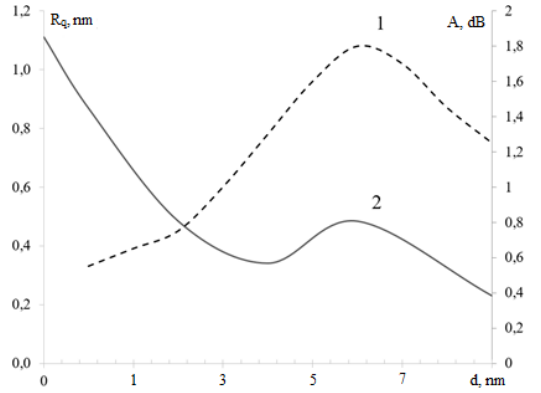
Fig. 4. Dependence on film thickness: 1 – attenuation coefficient; 2 – surface